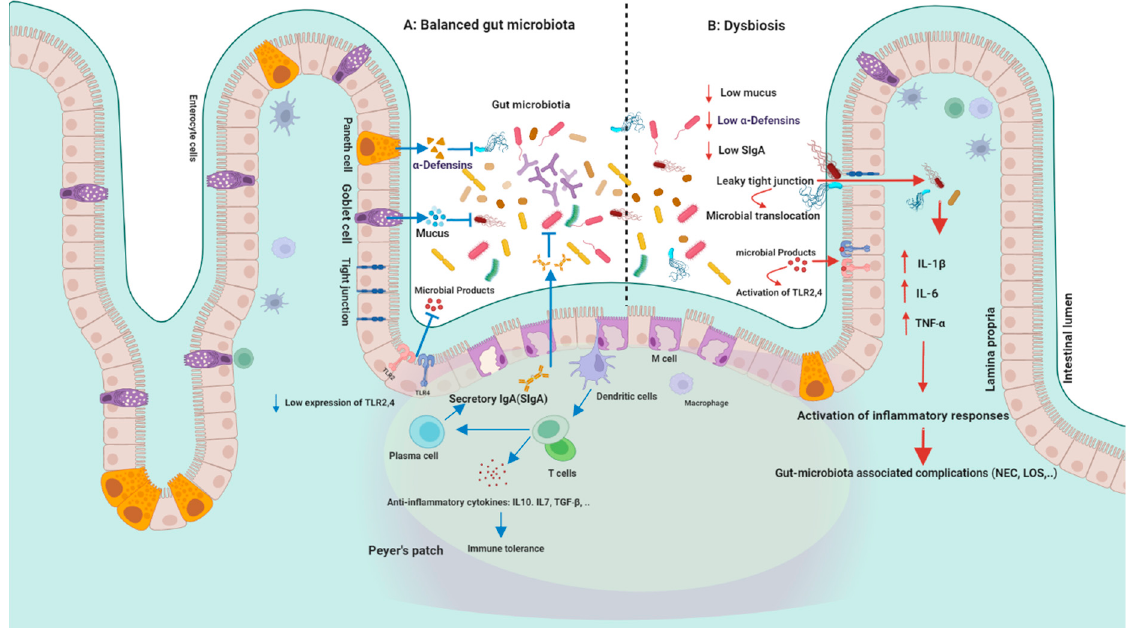
Figure 2. Gut microbiota and immunity: ( A ) in healthy conditions: intestinal epithelial cells provide a protective layer between intestinal mucosa and luminal microorganisms. Goblet and Paneth cells secrete mucus layer and antimicrobial peptides. Secretory immunoglobulin A (sIgA) secreted by B cells have protective roles against luminal microbiota. While controlling permeability and microbial translocation, epithelial tight junctions (TJs) between intestinal cells maintain the integrity of the intestinal barrier. Gut microbiota-immunity crosstalk can activate different immunological pathways either in a regulated or exaggerated way and lead to the development of several diseases. Host-microbe interaction is activated through different recognition receptors, which are highly expressed in intestinal epithelial cells (IECs) such as TLRs. PRRs activation can lead to the production of different antimicrobial peptides such as α -defensins. Host-microbe interaction can influence T cell differentiation into Th1, Th2, Th17, and Treg cells, which are regulated by pro-inflammatory and anti-inflammatory cytokines such as TGF β and IL-10. ( B ) Dysbiosis; recognition of microbial compounds (such as Gram-negative lipopolysaccharide) by TLRs leads to the activation of MYD88 and the production of several inflammatory cytokines. TLR4 stimulation by Gram-negative bacteria causes enterocyte death and mucosal injury. TLR2 (TLR1 and TLR6) can also recognize Gram-positive bacteria. The interaction of TLRs and microbial signals leads to the activation of a cascade of immune responses. Increased intestinal permeability, TJ disruption, and subsequent uncontrolled translocation of microbial pathogens (leaky gut) can lead to several gastrointestinal diseases. Figures in this manuscript were created specifically for this manuscript in BioRender.com, accessed on 15 August